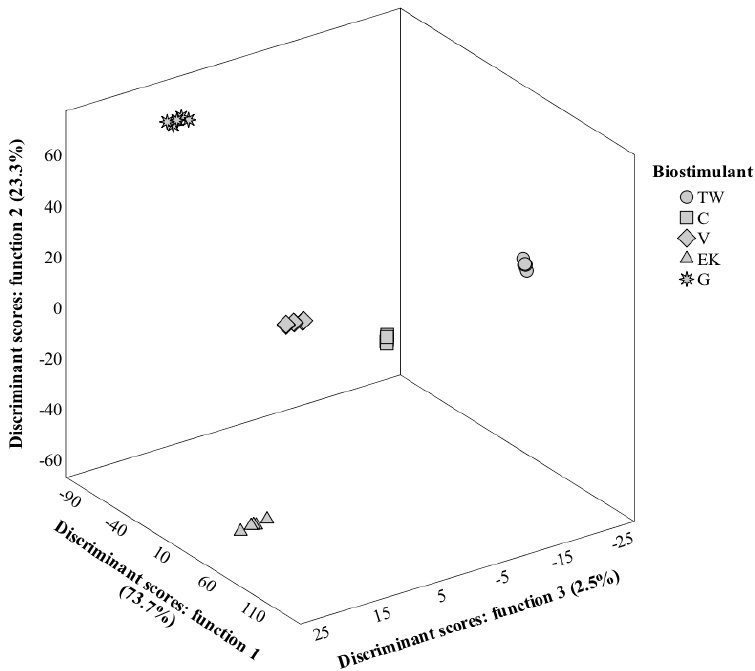
Figure 3. Canonical discriminant functions coefficients defined from the evaluated parameters plotted to show the effect of biostimulants treatments on Phaseolus vulgaris green pods of the second harvest under different irrigation regimes (normal irrigation and water stress).